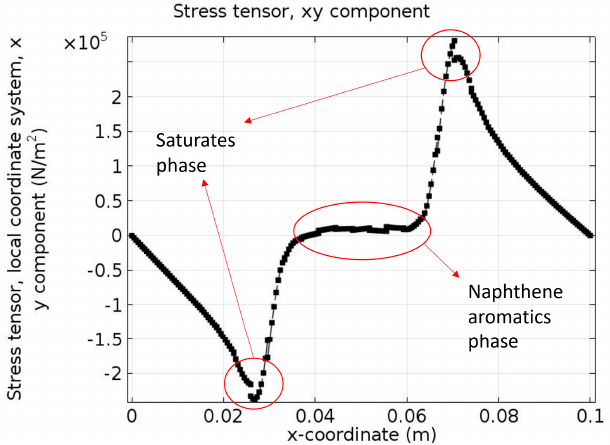
Figure 14. xy component of stress tensor of bottom boundary at t = 0.5 s.